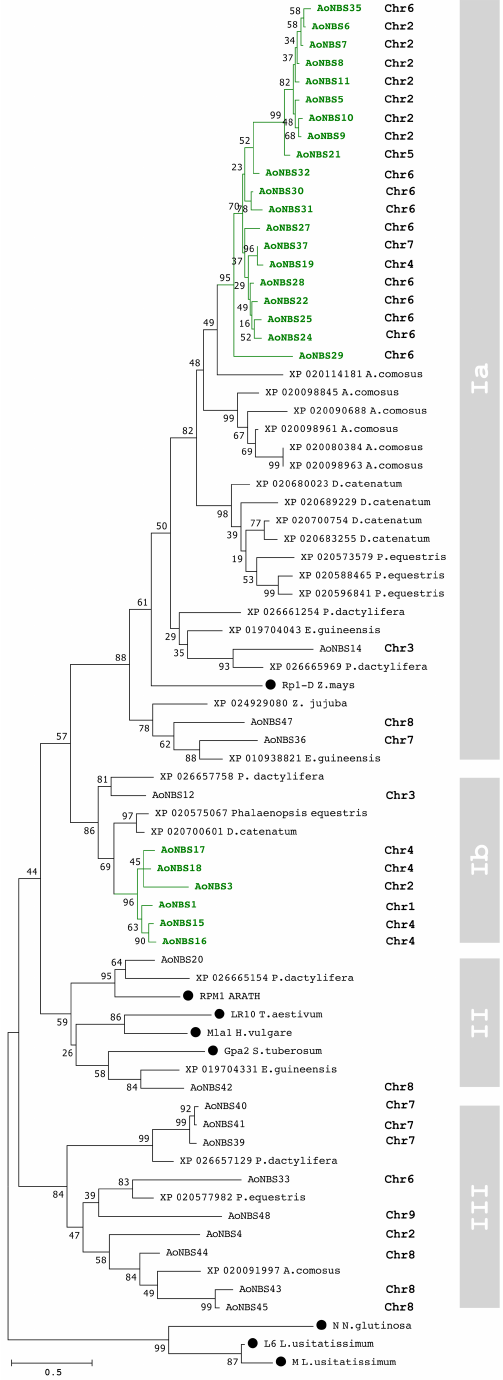
Figure 2. Phylogenetic relationships in asparagus. Maximum likelihood tree based on the NBS domain. Forty-one A oNBS were classified into four subclasses. The known resistance ( R) -genes used for construction of the tree are marked with solid black circles. Their accession numbers are: Mla1 (AAG37356), Gpa2 (AAF04603), Lr10 (AAQ01784), RPM1 (Q39214), Rp1-D (AAD47197), N (AAA50763), L6 (AAA91022), and M (AAB47618). Scale bar represents the number of substitutions per site. Asparagus-specific clades are shown in green